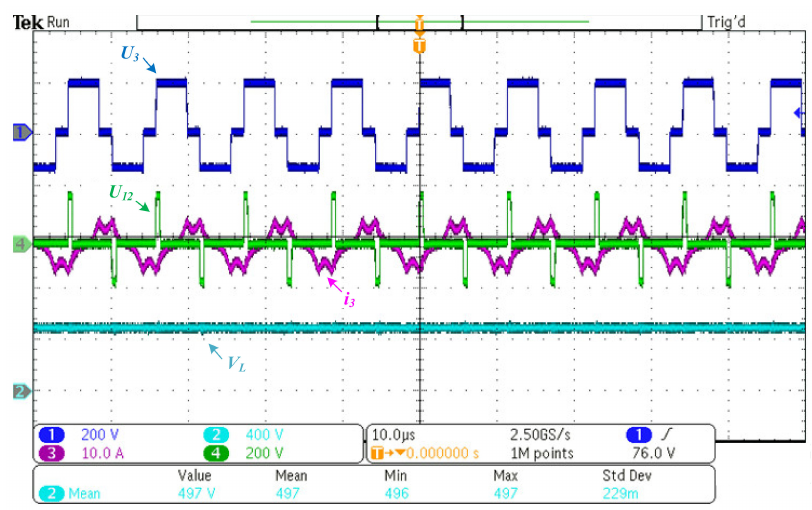
Figure 16. The key waveform after the switching